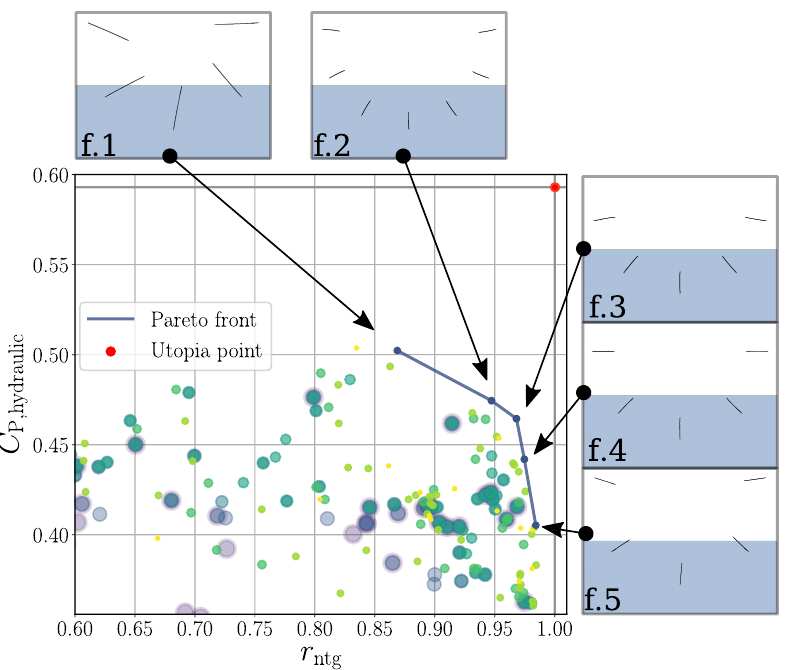
Figure 7. The top-5 best evaluations (Pareto front) of the optimisation, connected with a thick blue line. The respective geometries are also depicted. Dots indicate evaluations, with their colour and size indicating the generation they were produced in. The scales of both axes is such that only a portion of evaluated candidates are